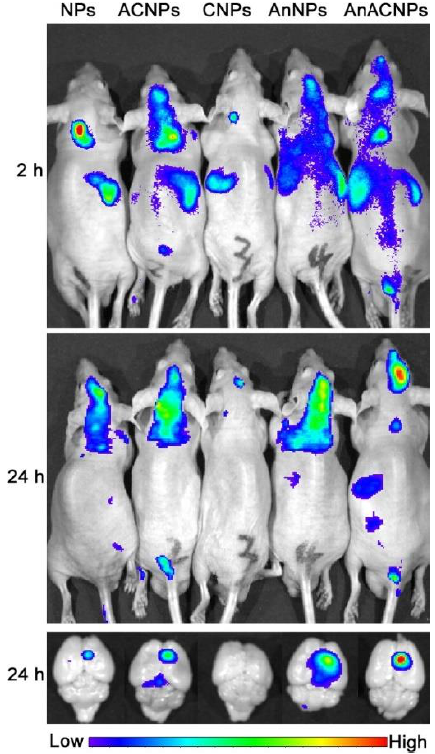
Figure 3. In vivo imaging of whole body and ex vivo imaging of brain from mice that were treated with different DiR-loaded formulations. Adapted from Molecular Pharmaceutics with permission from the American Chemical Society, published by American Chemical Society 2014, Copyright 2014